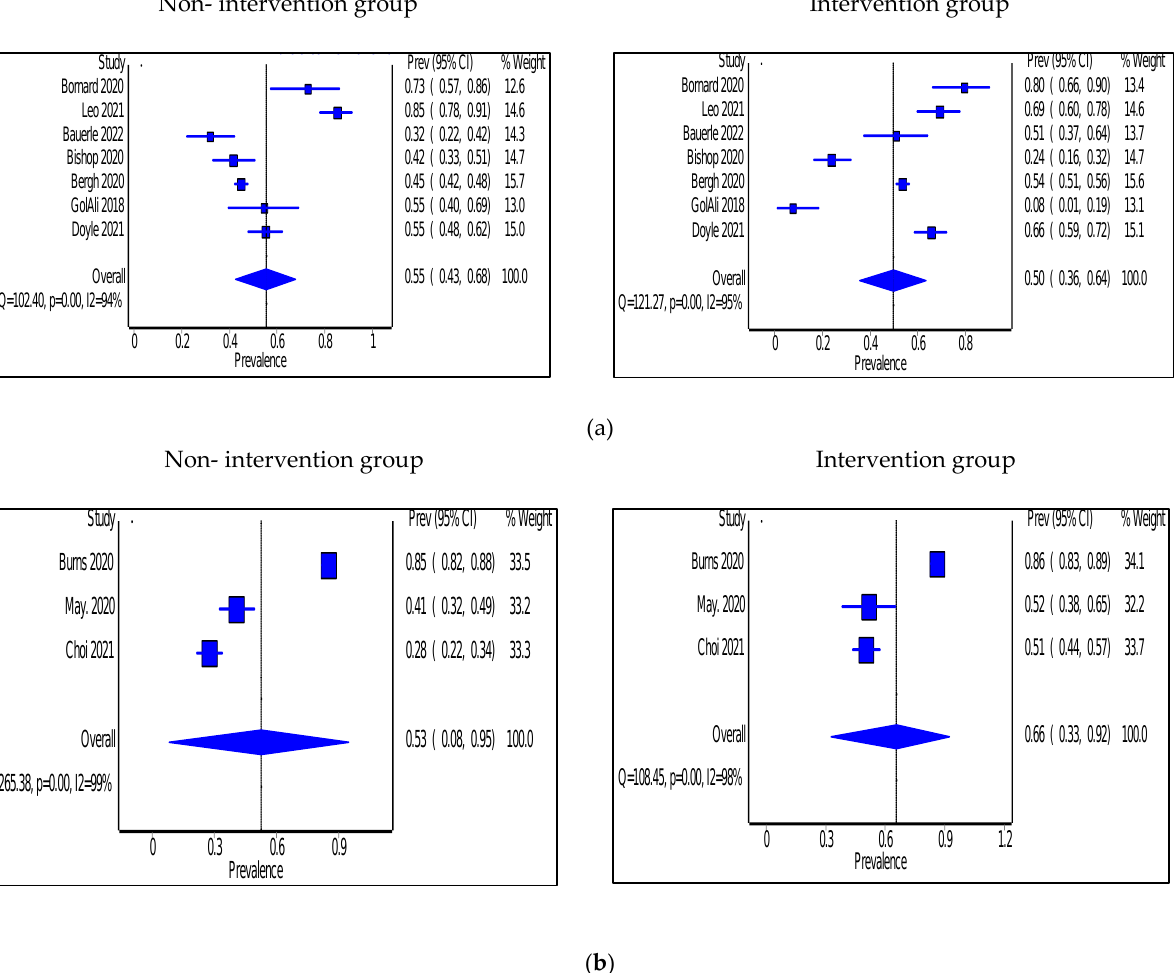
Figure 7. ( a ) Prevalence of patients prescribed antibiotics in accordance with hospital guidelines within the inpatient setting in the non-intervention and intervention groups; ( b ) Prevalence of patients prescribed antibiotics in accordance with hospital guidelines within the outpatient setting in the non-intervention and intervention groups.